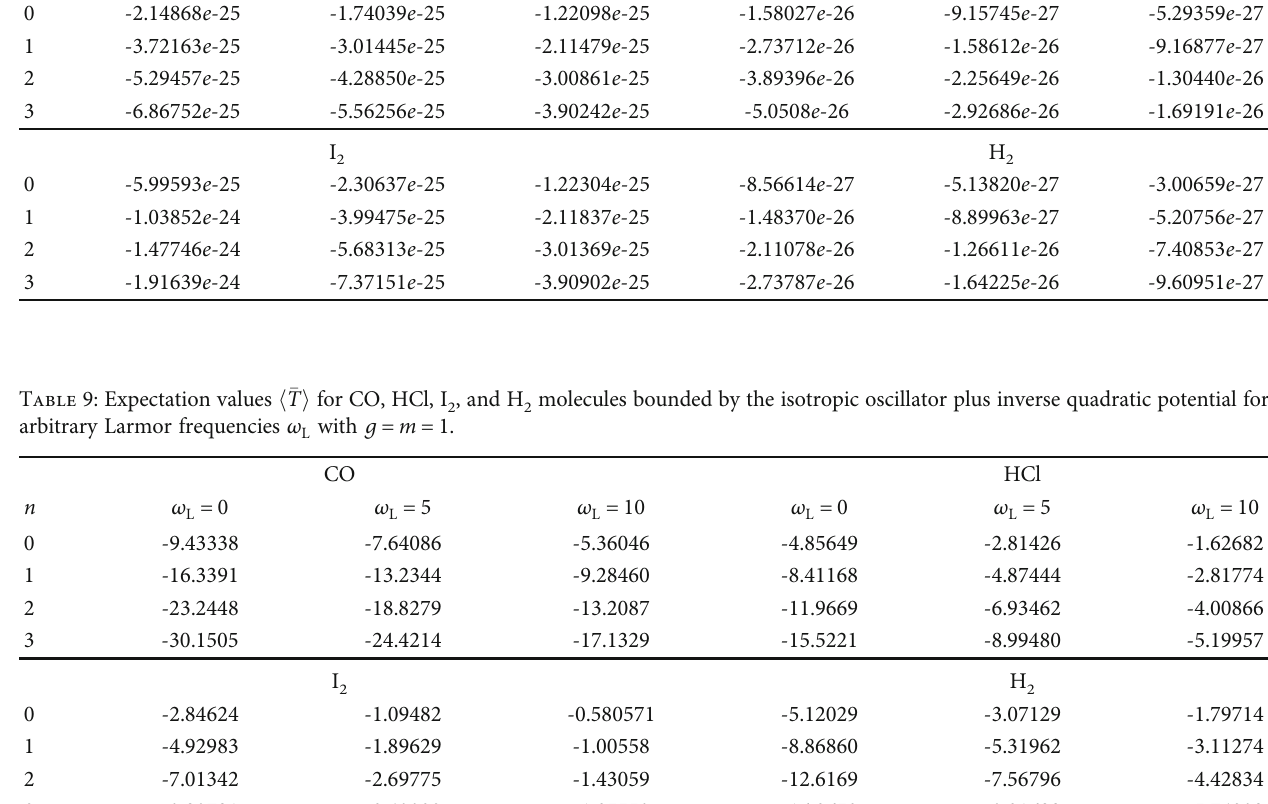
Table 10: Expectation values h (cid:1) V i for CO, HCl, I